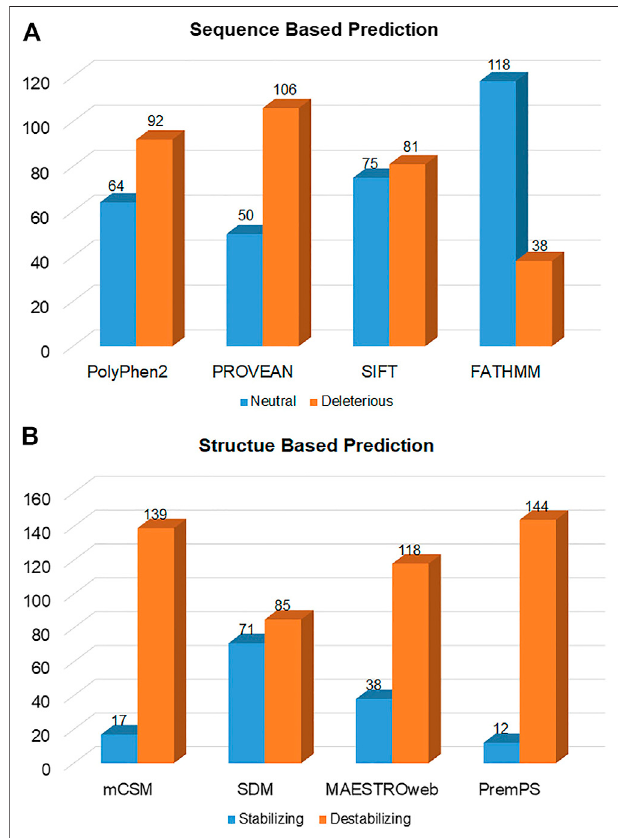
FIGURE 3 | Deleterious and neutral mutations in SGK1 predicted by (A) sequence-based and (B) structure-based tools.